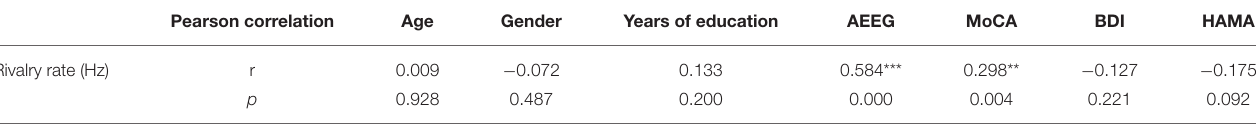
TABLE 3 | Correlations of demographic and clinical characteristics with rivalry alternation rate in the IGE group ( n = 94). Pearson correlation